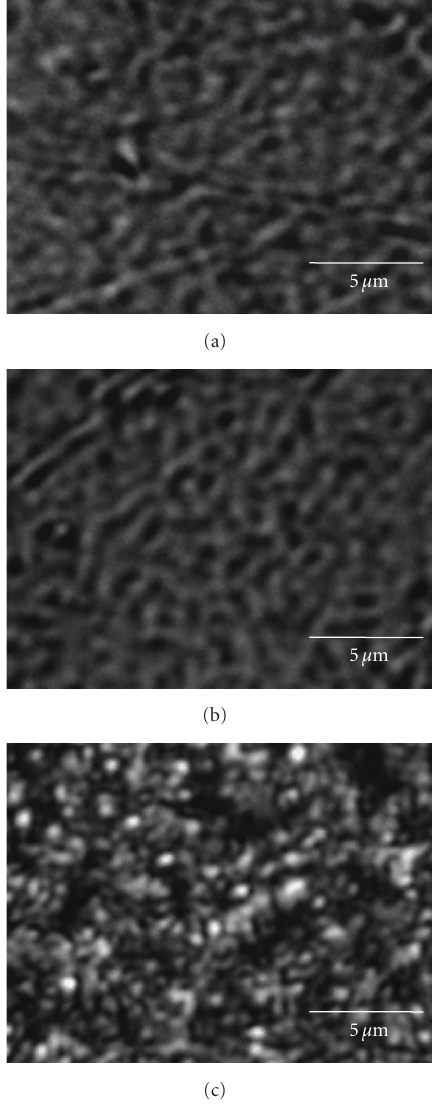
Figure 6: Microphotographs of the surface morphology of the Cu +5T-films with the thickness of (a) 150nm, (b) 440nm, and (c) 730nm.